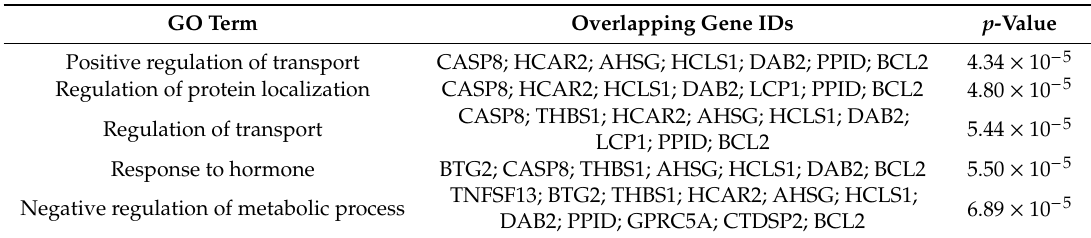
Table 2. Top five gene ontologic terms populated by a CPDB over-representation analysis of the